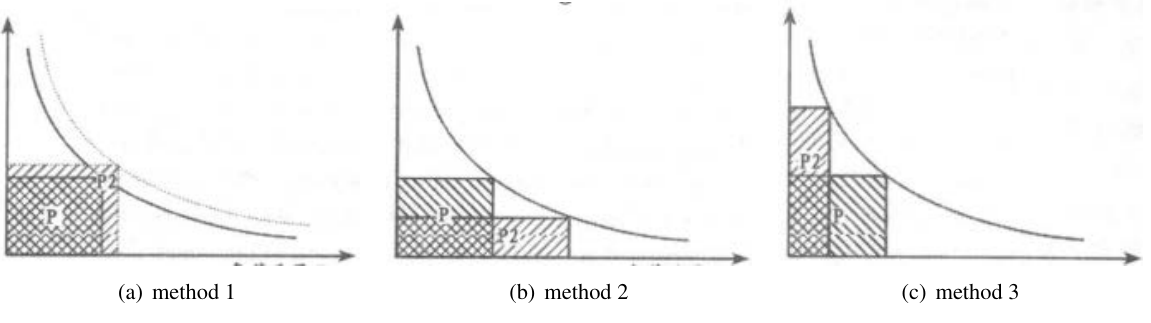
Fig. 1 Three ways to increase the maximum burst